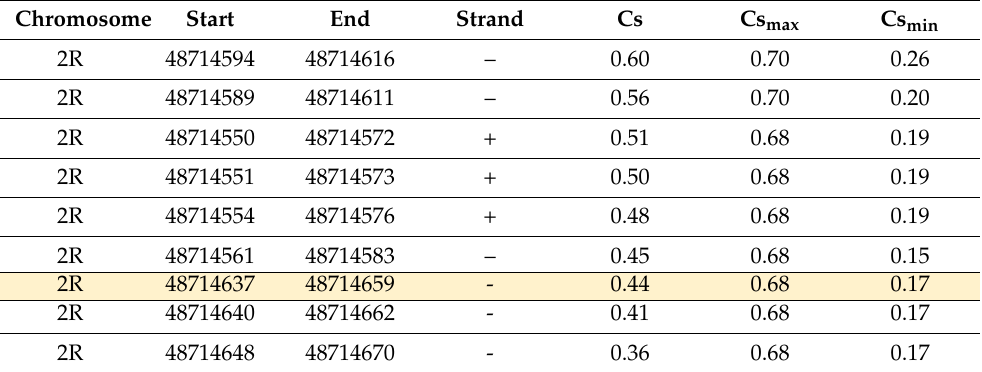
Table 1. Alternative gene drive target sites in the coding sequence of exon 5 in dsx gene. The existing gene drive target site is